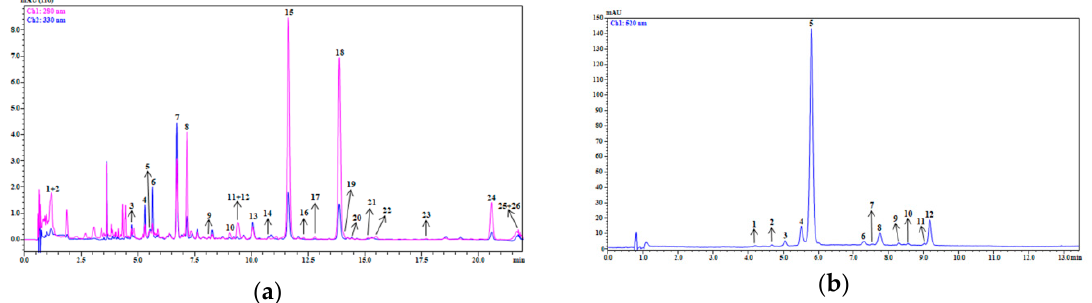
Figure 1. Chromatogram profiles ( λ : 280 nm and λ : 330 nm; pink and blue lines, respectively) of polyphenols isolated from Citrus sinensis smoothie ( a ) and anthocyanins ( λ : 520 nm) extracted from Vitis vinifera L. cv. Aglianico N smoothie ( b ). ( a ): #1: quinic acid; #2: caffeoylquinic acid; #3: